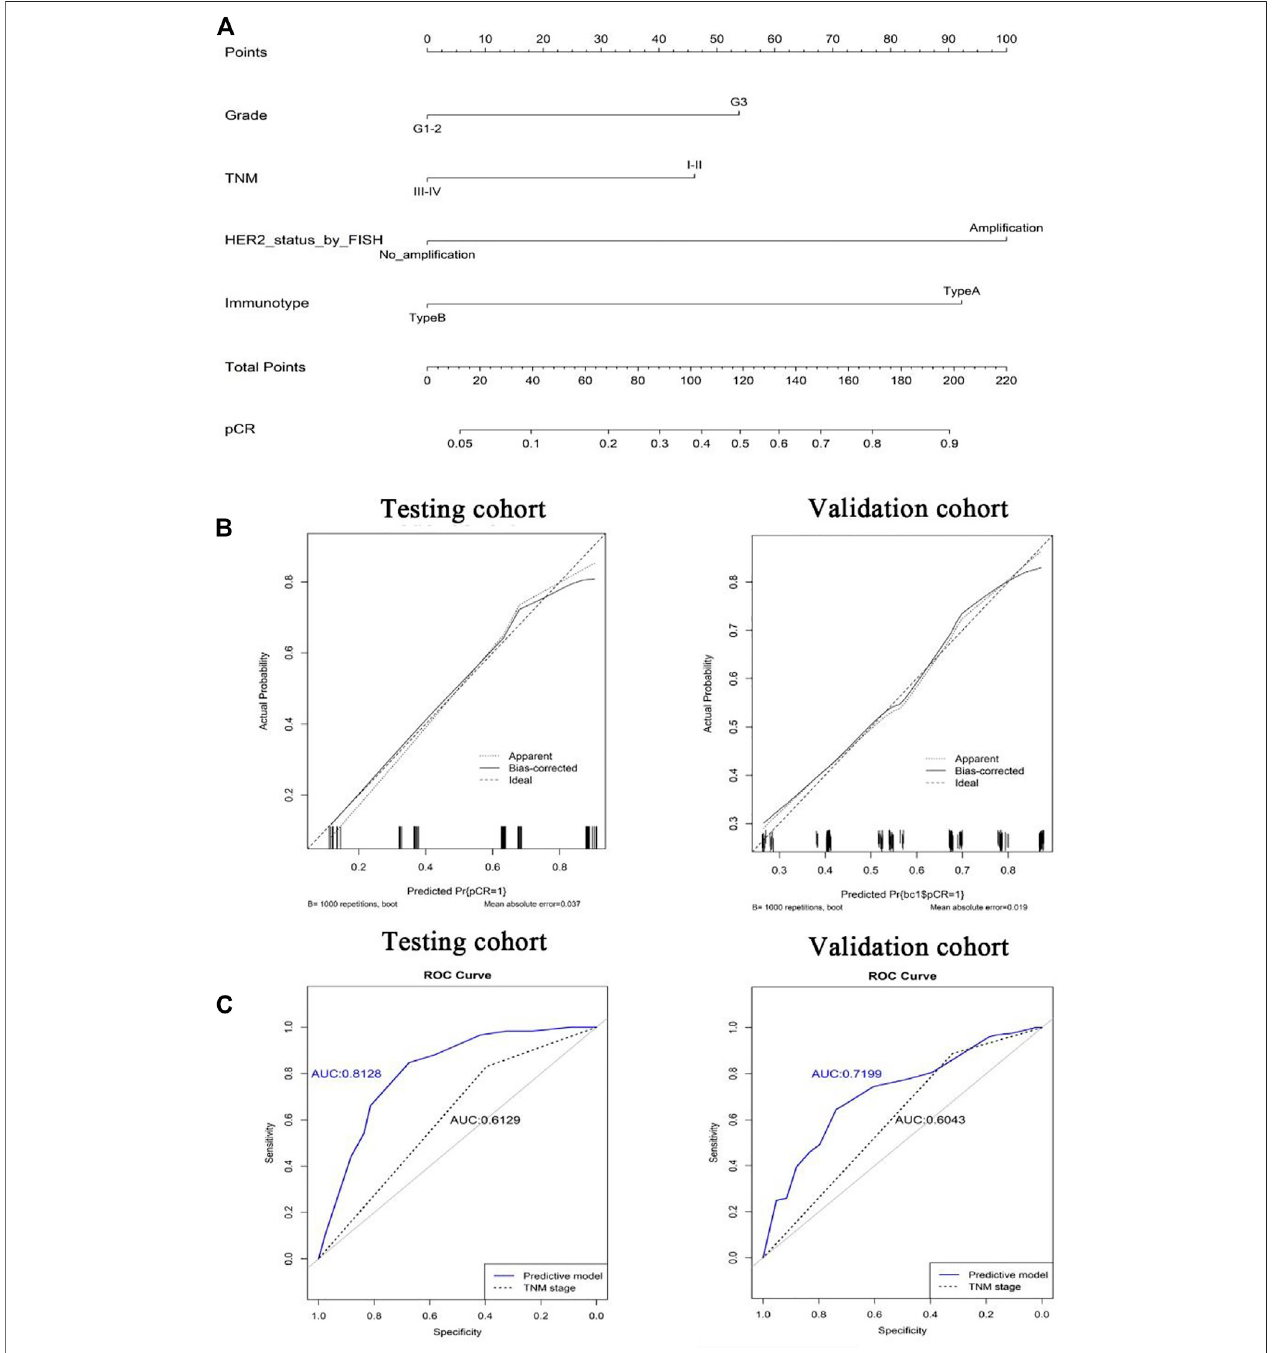
FIGURE5| Nomograms(forpCR)thatintegratedtheimmunotypeandclinicopathologicriskfactors (A) .Calibrationcurvesshowingthediscriminatorypowerofthe nomogramforpCR intestingand validationcohorts (B) .ROCcurvesshowingthepredictiveaccuracyofthenomogram forpCR andthepredictive accuracywashigher than that of the TNM staging system in both testing and validation cohorts (C)